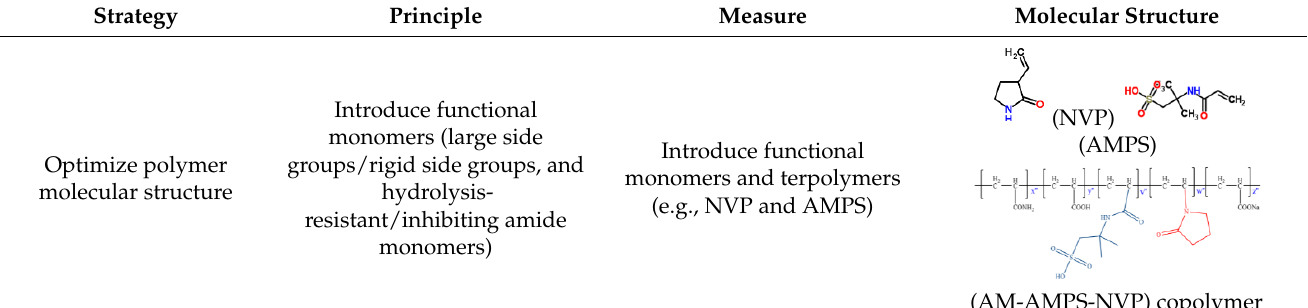
Table 1. Methods to improve the temperature resistance of polymer gel.